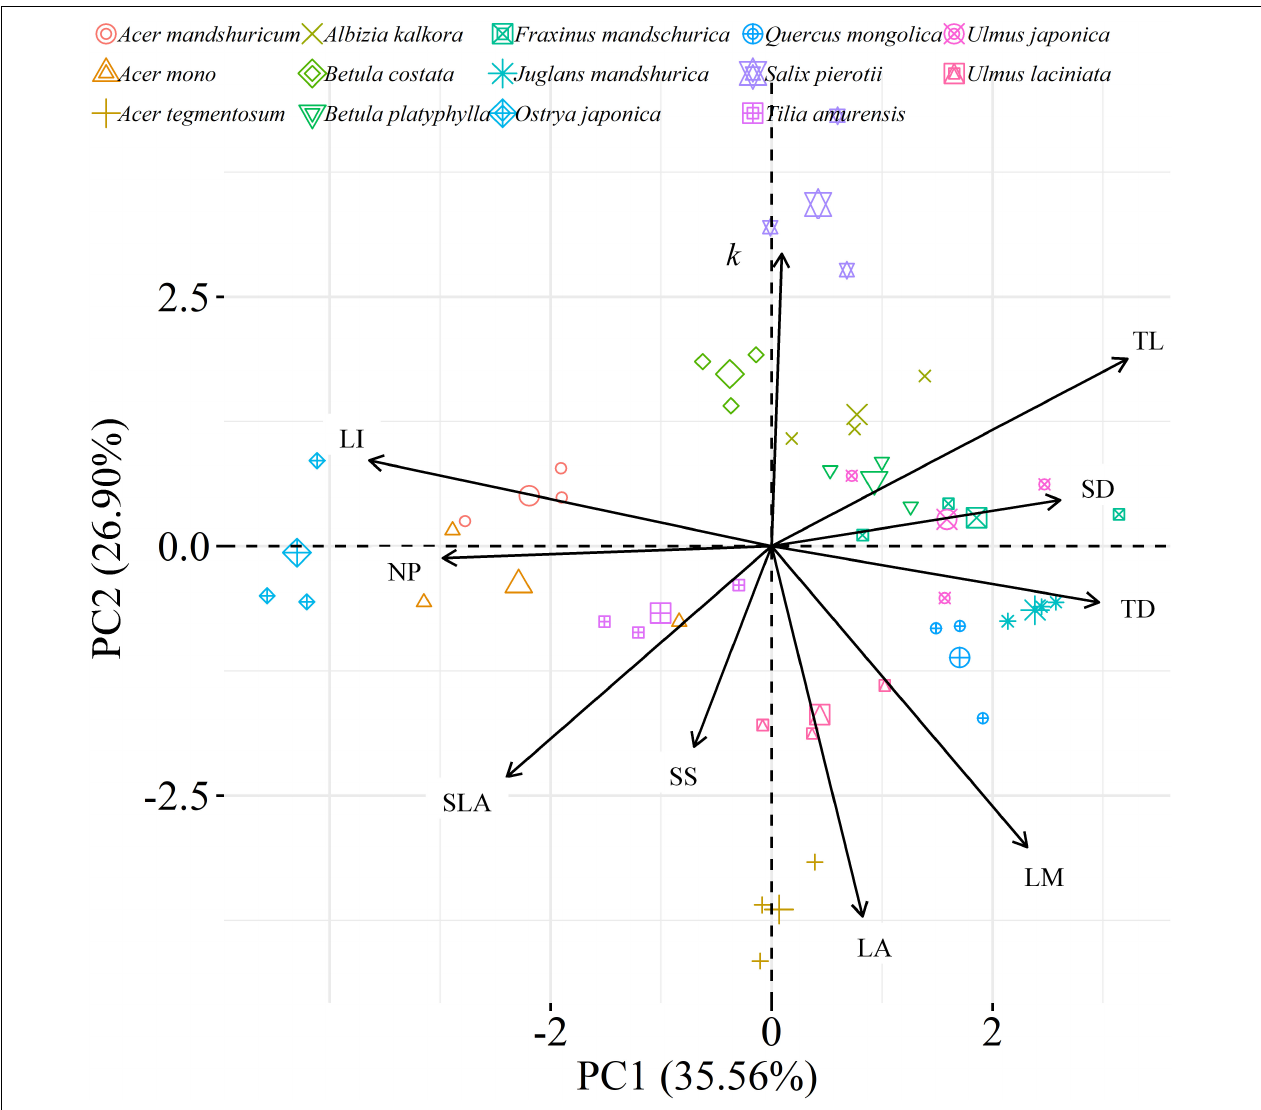
FIGURE 6 | Principal component analysis (PCA) among leaf, twig, stoma traits and leaf water loss rate as well as species distribution in the two-dimensional trait space [three points of tree species values (smaller points) and their average values (larger points)]. All data were log e -transformed before analysis. k , leaf water loss rate; TL, the length of twig; TD, the diameter of twig; LI, leafing intensity; SLA, specific leaf area; SS, stomatal size; SD, stomatal density; LA, individual leaf area; LM, individual leaf mass; NP, the ratio of leaf nitrogen to phosphorus